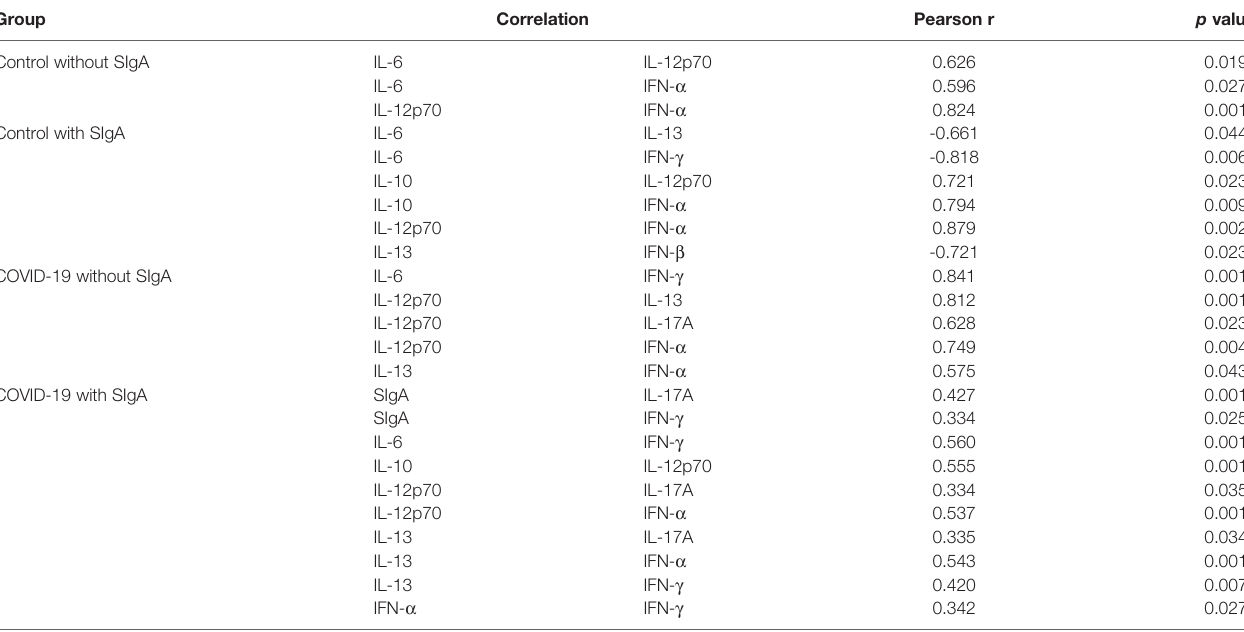
TABLE 2 | Signi fi cant correlations between analysis of SIgA and cytokines of COVID-19 and control with and without SIgA groups. Group Correlation Pearson r Control without